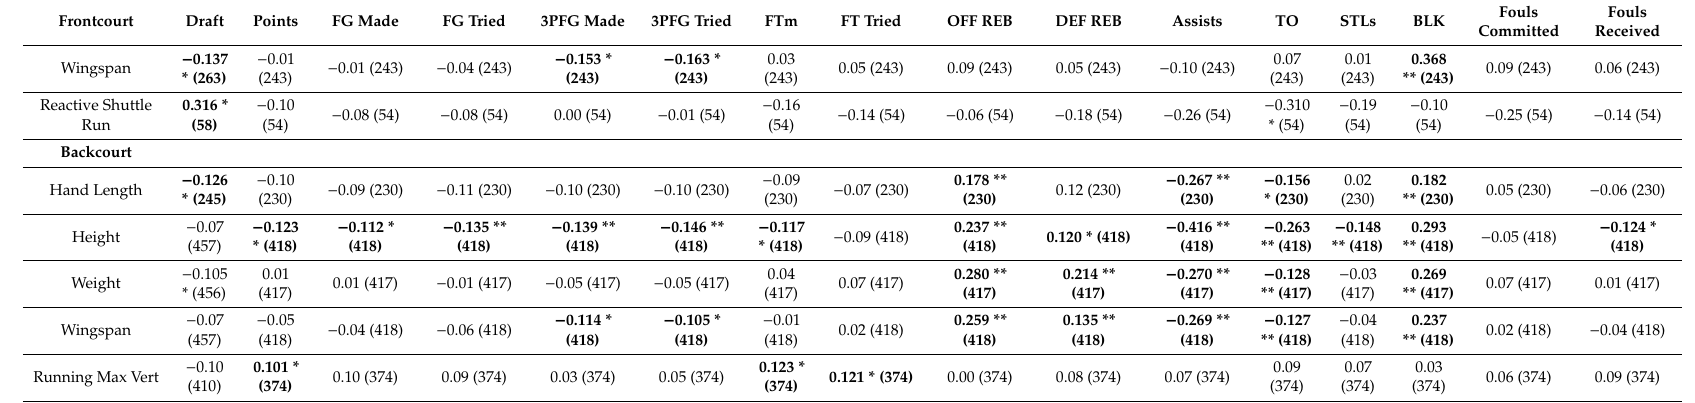
Table 3. Pearson correlation coe ffi cients between COMBINE measures and game performance indicators in Frontcourt and Backcourt players (r value and